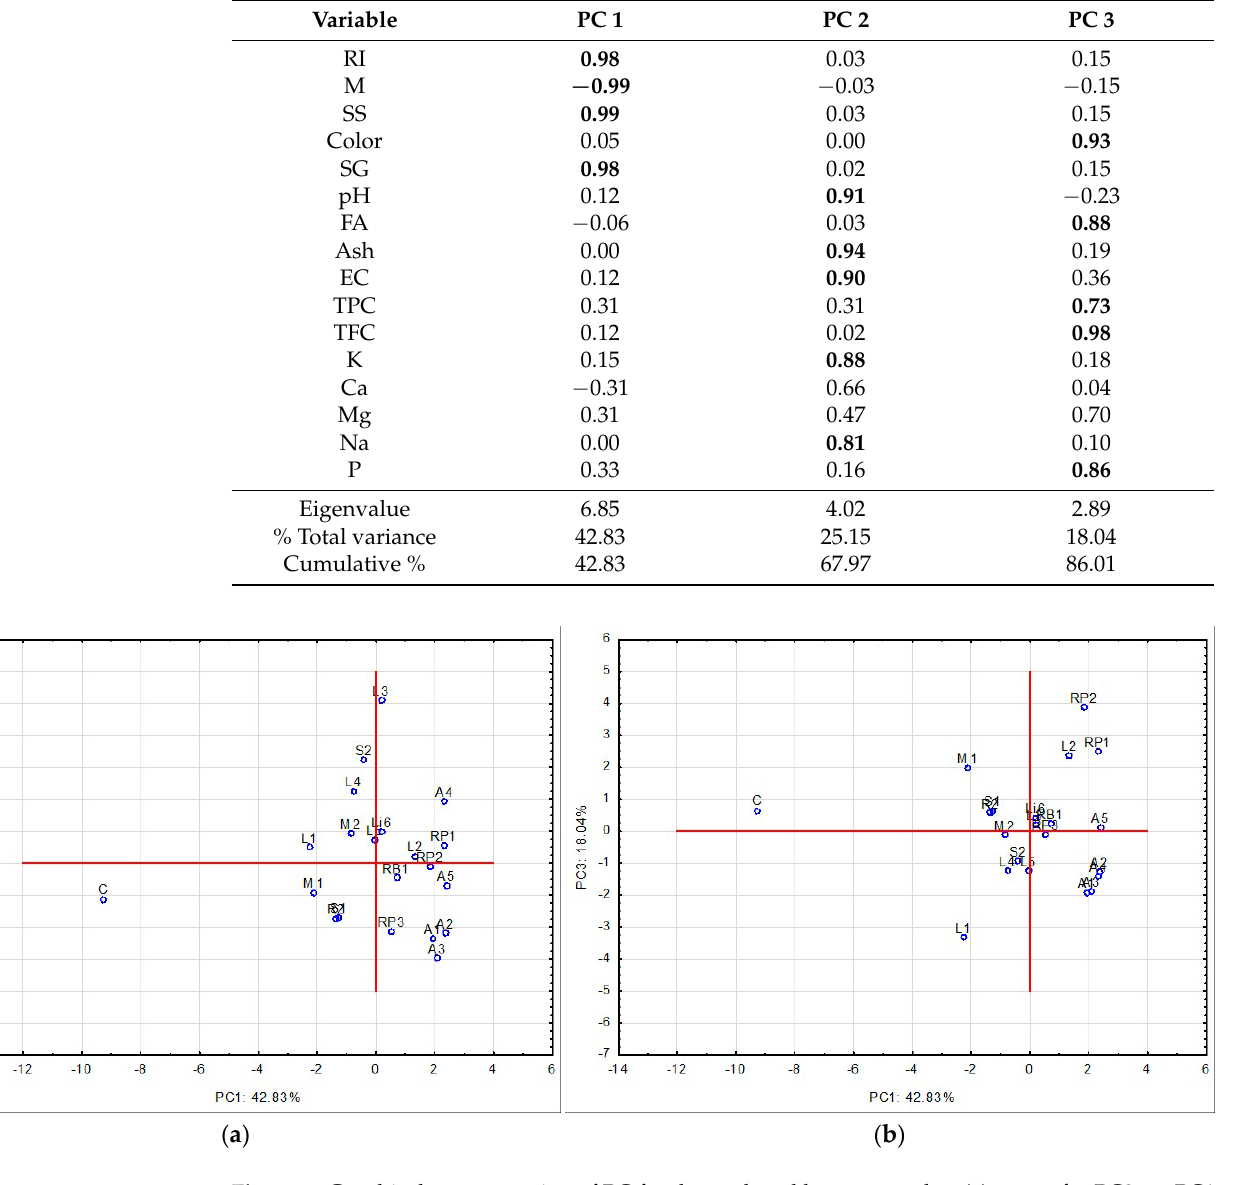
Figure 6. The hierarchical dendrogram of cluster analysis for the analyzed honey samples based on the determined quality parameters. K